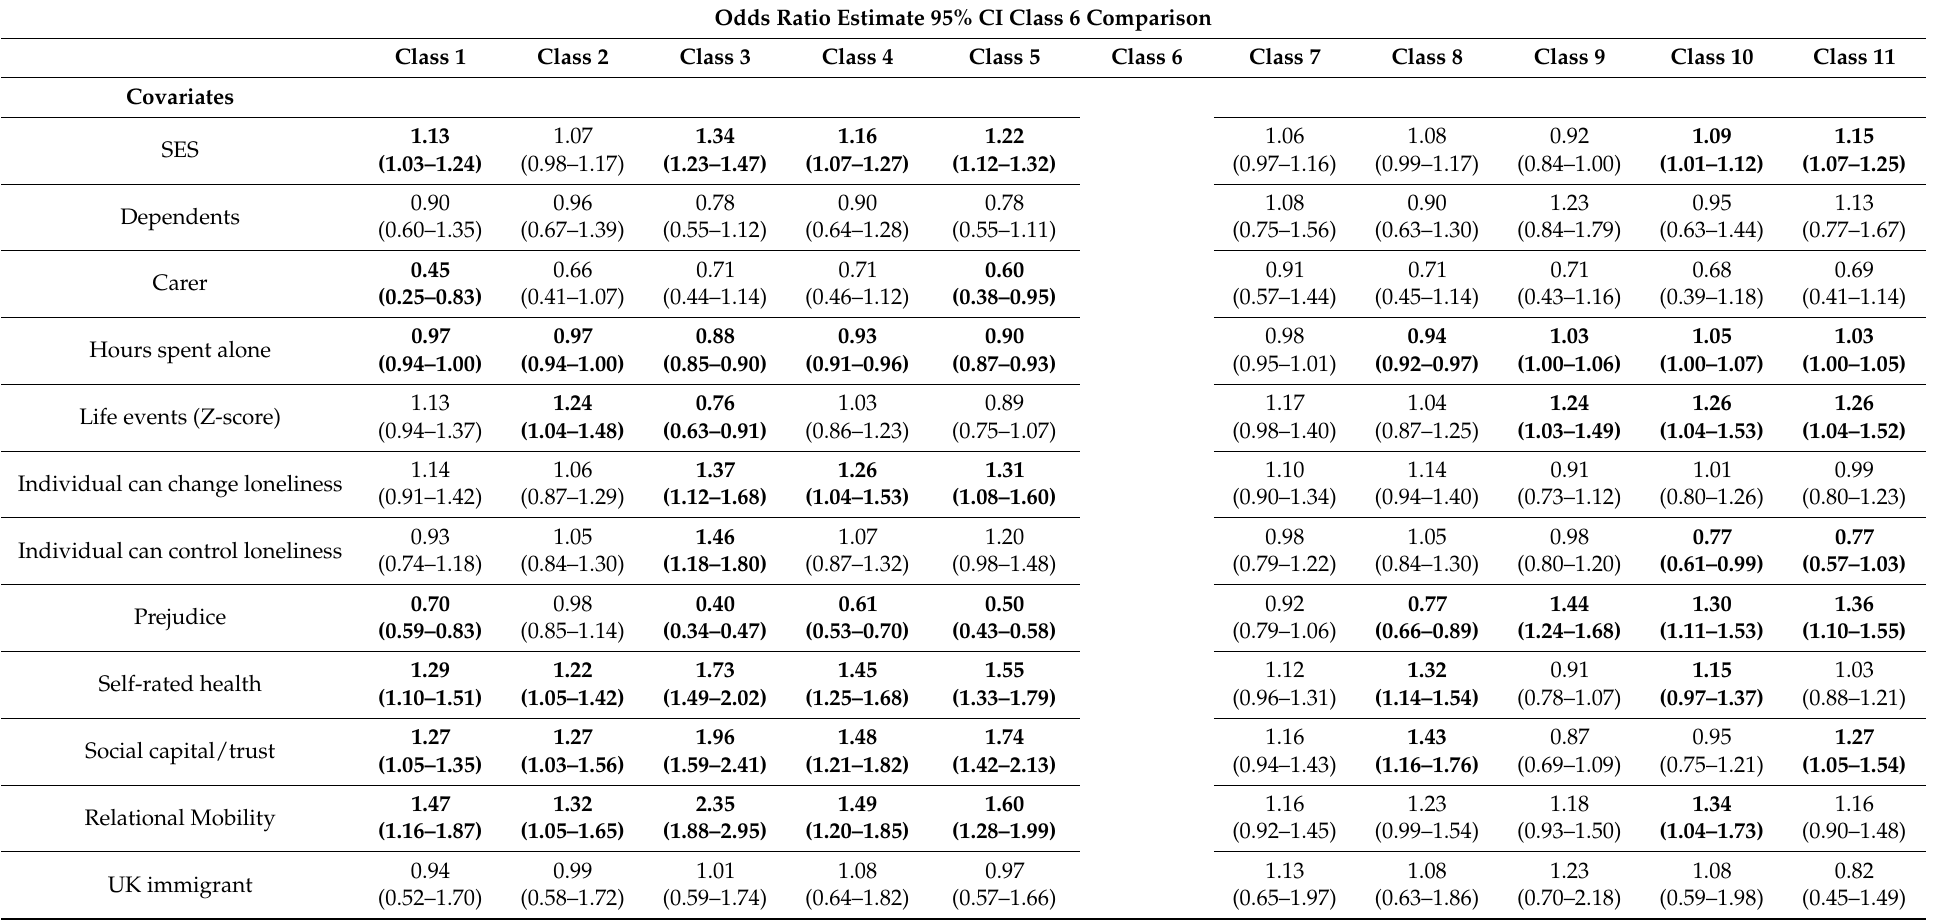
Table 6. Odds ratios (and 95% confidence intervals) showing the relationship between the lonely classes and other classes for the predictor